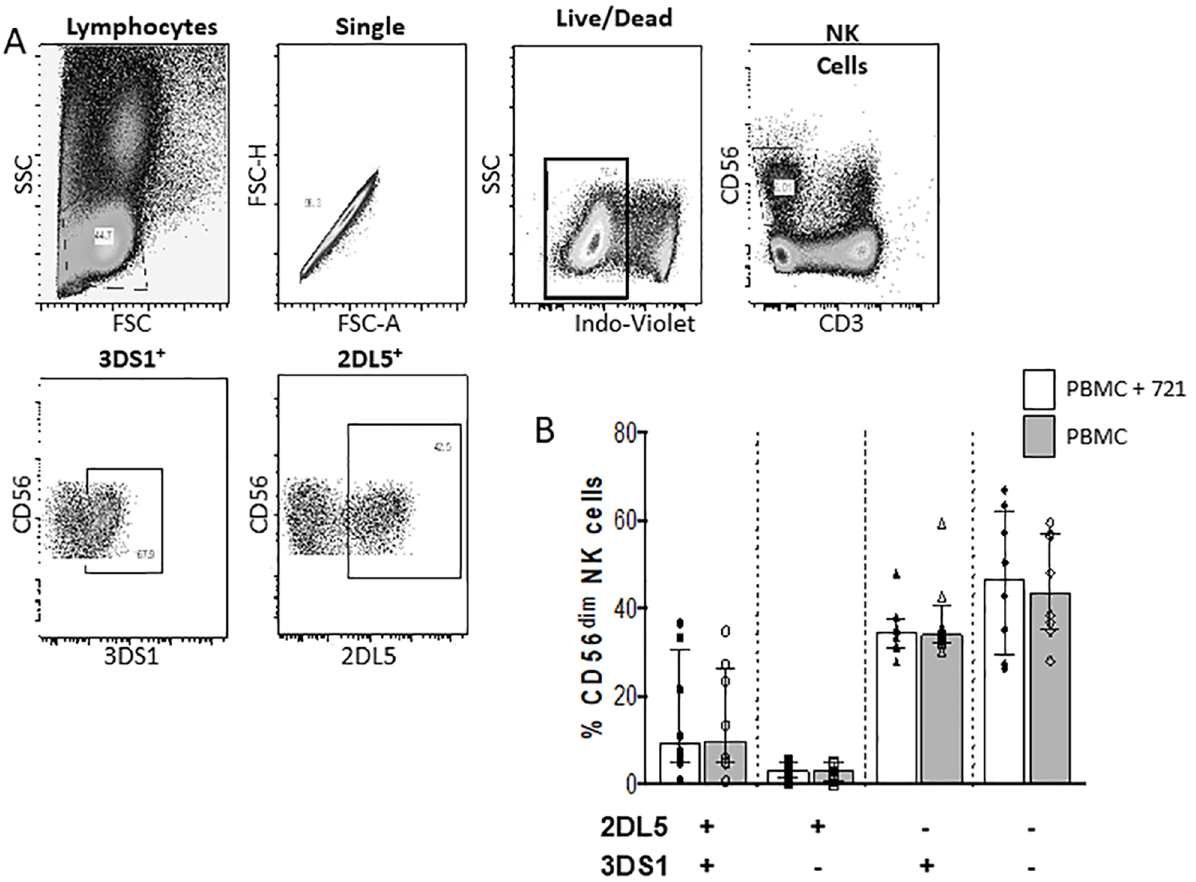
Fig 4. The frequency of NK cells expressing all possible combinations of KIR3DS1and KIR2DL5 before and after stimulation with 721.221(221) HLA-null cells. (A) Live singletlymphocytes were gated on. From this populationCD3 - CD56 dim NK cells were examinedfor the frequencyof cells expressingKIR3DS1 and/or KIR2DL5 or neither. (B) The frequency of NK cells on the y-axis expressingall possible combinations of KIR3DS1 (3DS1) and KIR2DL5 (2DL5)on NK cells before and after stimulationwith 221 cells (B). Each point represents results from a single individual. Bar heightsand error bars represent the medianand inter-quartile range of each group.